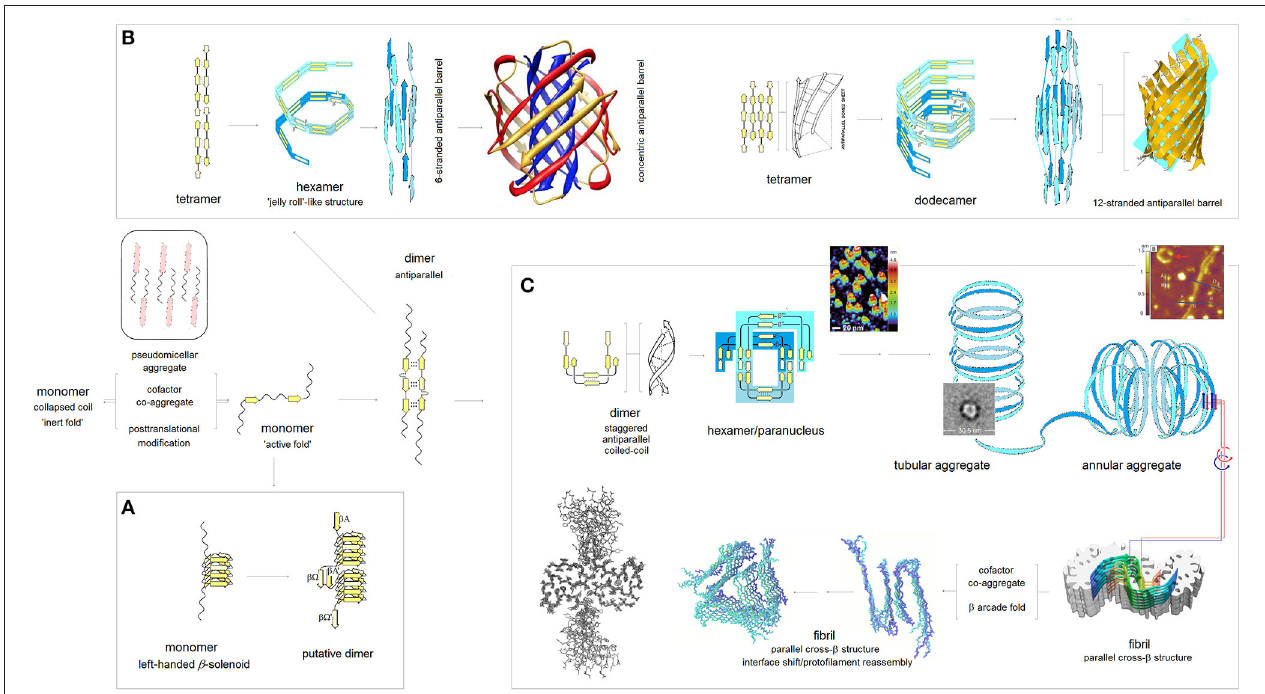
FIGURE 3 | The PMO theory of misfolding and aggregation of pleiomorphic proteins associated with common brain proteinopathies. Based on the PMO theory of protein secondary and tertiary structure (Cieplak, 2017) and conformational properties of β sheets (Salemme, 1983; Branden and Tooze, 1999), polymerization of A β , tau, α S and PrP C is initiated by an “active” fold of the intrinsically disordered amyloidogenic region of a monomer. The “gain-of-structure” for the disordered region is realized either by folding into a β solenoid (A) , or coupled binding and folding into an antiparallel dimer by analogy to the coupled binding and folding of split inteins, which may lead to (i) antiparallel β barrel structures (B) , or (ii) parallel cross- β structures (C) . (A) Formation of the β solenoid structures: Folding of β solenoids is assumed to require the presence of a sequence of alternating “C 7eq strand” and “C 5 strand” propensities (in the parallel alignment, the free energy of the backbone-backbone H-bonding is minimized, according to the underlying PMO theory, by the binding backbone segments with contrasting “strand” propensities e.g., C 7eq ↑ C 5 ↑ , cf. Figure 2 ), and a sequence of properly distributed residues capable of forming the stabilizing side-chain ladders (internal or external side-chain stacks, Branden and Tooze, 1999). So far, only the infectious PrP Sc is reported to adopt such a structure (Vázquez-Fernández et al., 2016; Wille and Requena, 2018). (B) Formation of the antiparallel β -barrel structures: The register of the initial antiparallel homodimers is determined by the pattern of “strand” propensities since the free energy of backbone-backbone H-bonding, according to the underlying PMO theory, is minimized in the antiparallel alignment by binding backbone segments of similar “strand” propensities e.g., C 5 ↑ C 5 ↓ or C 7eq ↑ C 7eq ↓ , cf. Figure 2 . The head-to-tail aggregation of extended conformers of such antiparallel dimers and tetramers is assumed to yield oligomers which by a combination of twist, bend and rise can fold into “jelly-roll”-like cylindrical structures and subsequently into β barrels. Depending on the extension of its core, the initial barrel may convert into a concentric β barrel ( Shafrir et al., 2010; Durell et al., 2018); while no such structures were actually isolated, this pathway seems to be consistent with a wide range of indirect evidence ( Durell et al., 2018). (C) Formation of the parallel cross- β structures: The head-to-tail aggregation of coiled-coil conformers of the antiparallel dimers is assumed to yield circular wedge-shaped paranuclei ( Fu et al., 2015; Economou et al., 2016); higher-order annular aggregates of such paranuclei are then expected to undergo conformational antiparallel-to-parallel β structure conversion to yield fibrils which assemble two protofilaments comprising parallel cross- β sheets and aligned in the antiparallel fashion ( Schmidt et al., 2015). A collapse of a cross- β